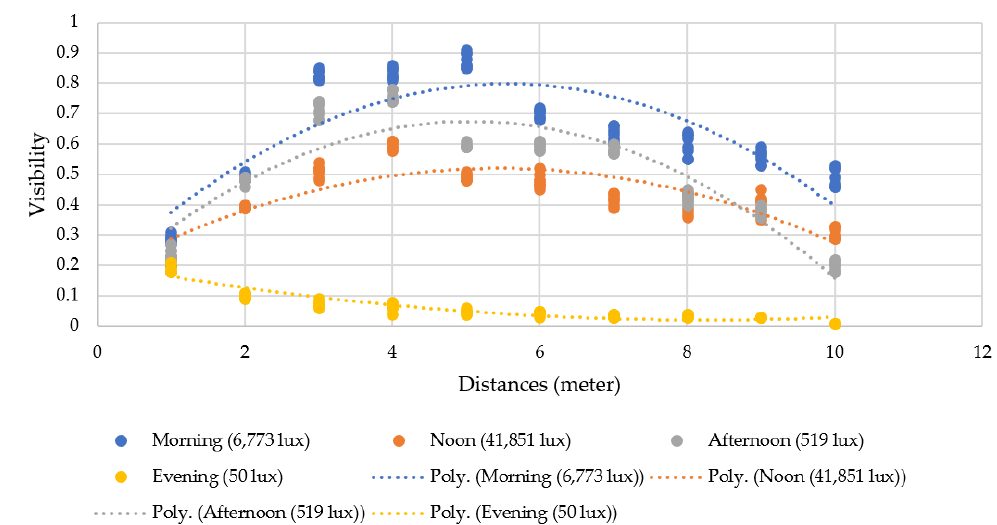
Figure 24. Relationship between visibility, light intensity, and